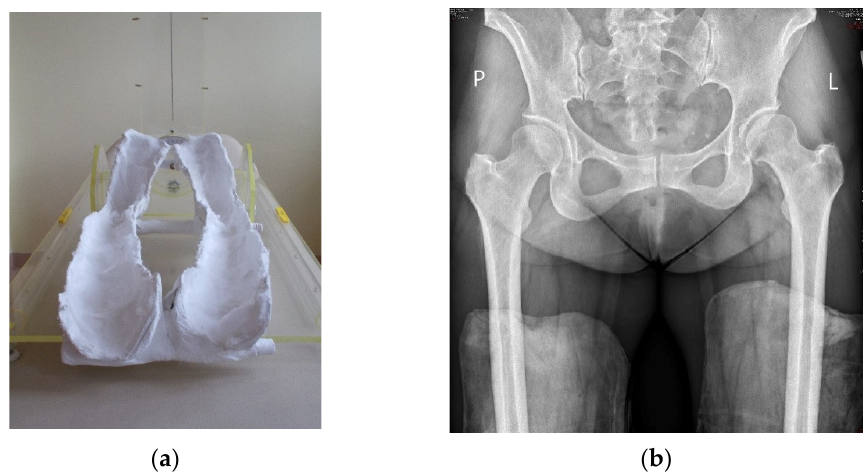
Figure 1. Plaster molds with 20-degree internal rotation of leg ( a ) in which AP digital radiographs were taken ( b ).